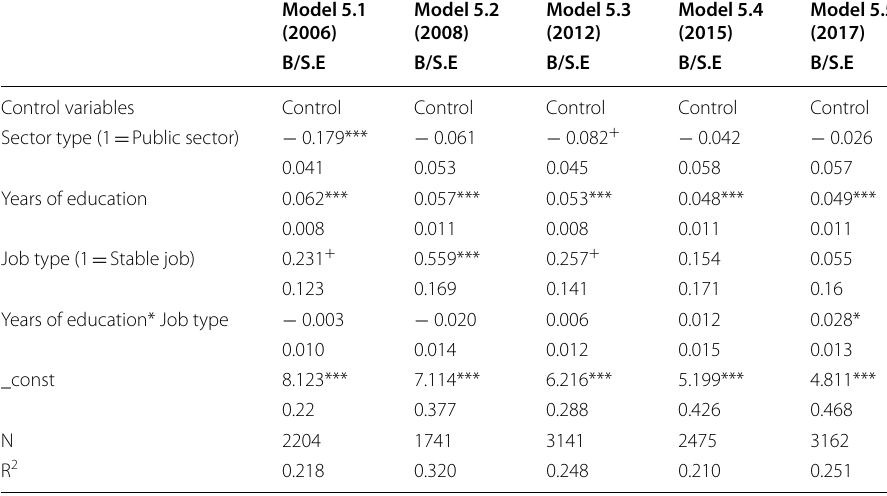
Table 6 Regression analysis of return on human